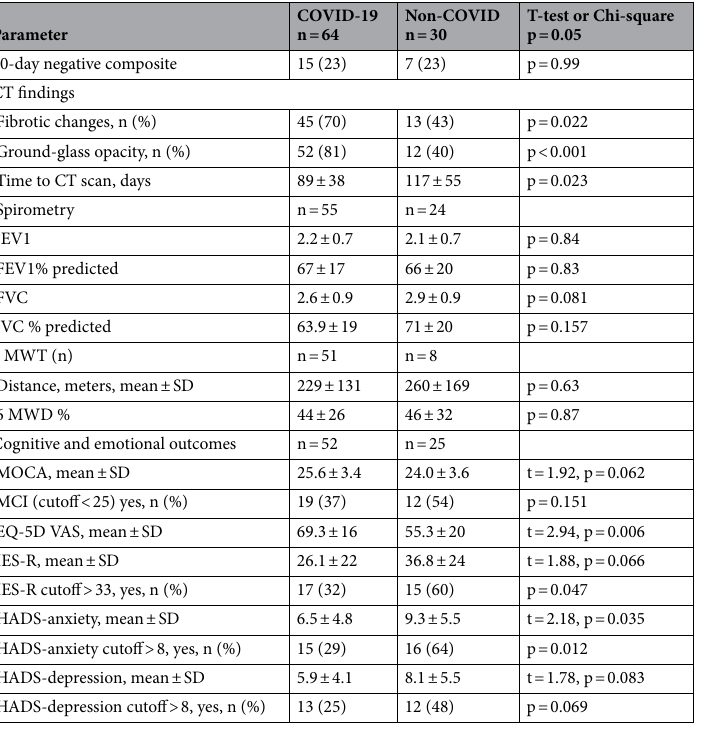
Table 2. Primary and secondary outcomes grouped by etiology of ARDS. ICU intensive care unit, LOS length of stay, LTAC long-term acute care facility, Acute acute rehabilitation facility, Home with HH home with